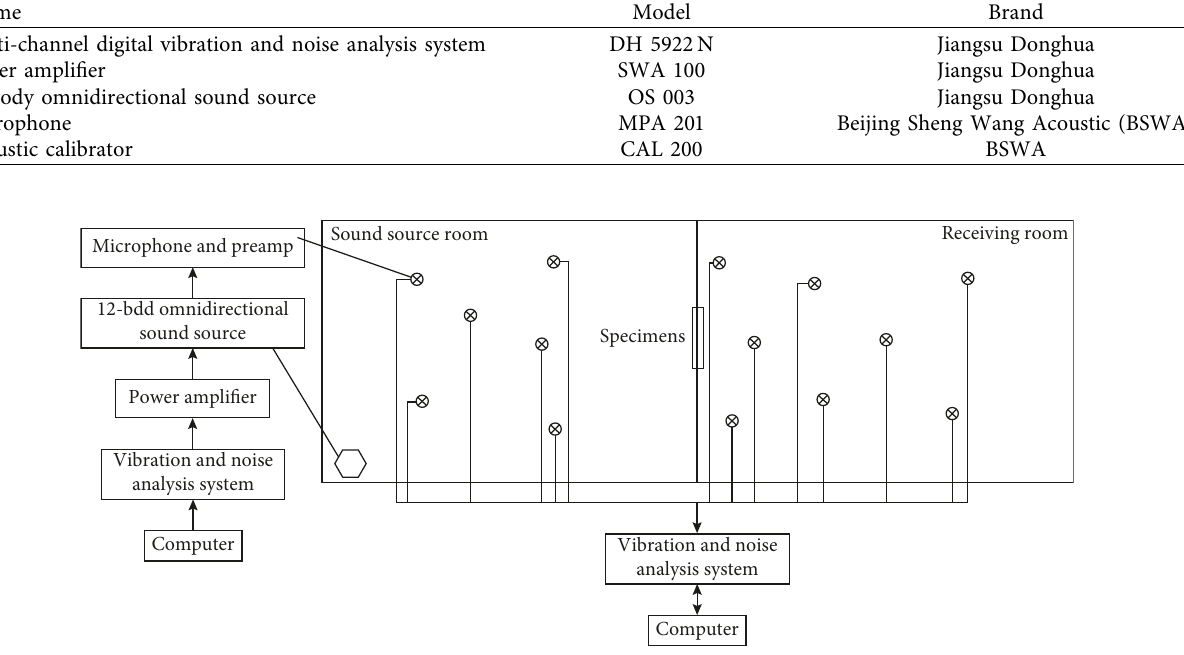
Figure 6: Sound pressure test block diagram.